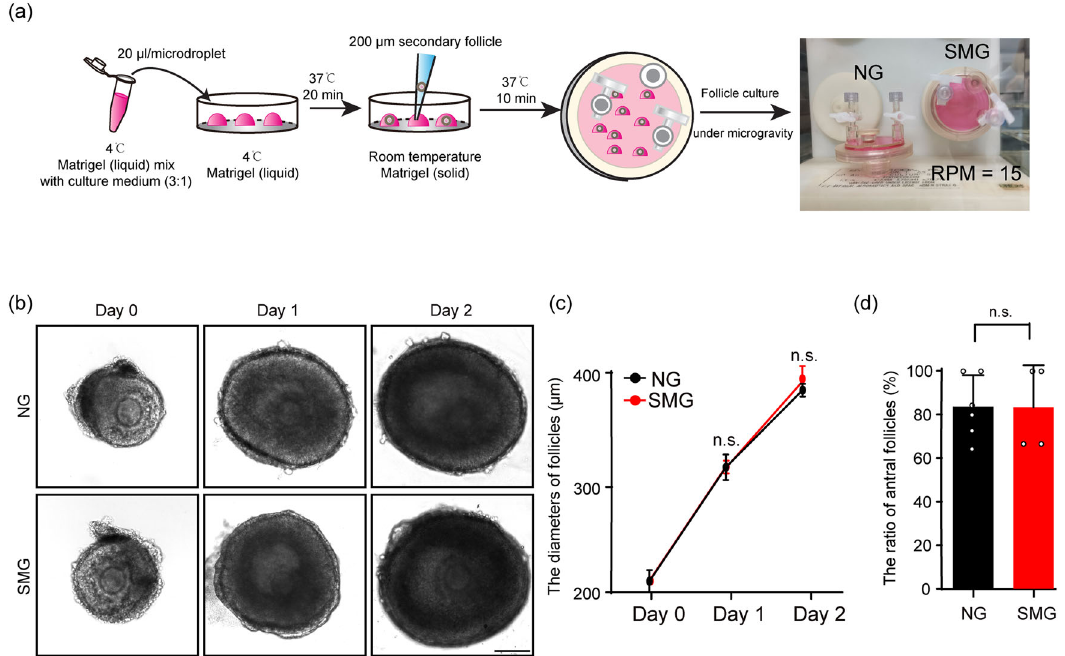
Fig. 1 Tracing the growth of ovarian follicles in a 3D culture system under simulated microgravity condition. a The fl owchart of the 3D ovarian follicle culture in RCCS. The follicles were seeded into a Matrigel droplet to support their growth. b , c Tracing the growth of ovarian follicles in the NG and the SMG groups in vitro ( b ), showing comparable developmental dynamics of follicles in the SMG groups ( n = 48) compared to that in the NG group ( n = 60) ( c ). Day 0: p value = 0.13. Day 1: p value = 0.43. Day 2: p value = 0.076. Scale bars: 100 μ m. d The ratio of antral formation in the cultured follicles under different conditions, showing no signi fi cant changes of antral forming proportions of cultured follicles in the SMG group ( n = 65) compared to that in the NG group ( n = 73). p value = 0.98. Representative images are shown. Data are presented as the mean ± SD. Data were analyzed by two-tailed unpaired Student ’ s t -test and n.s. P ≥